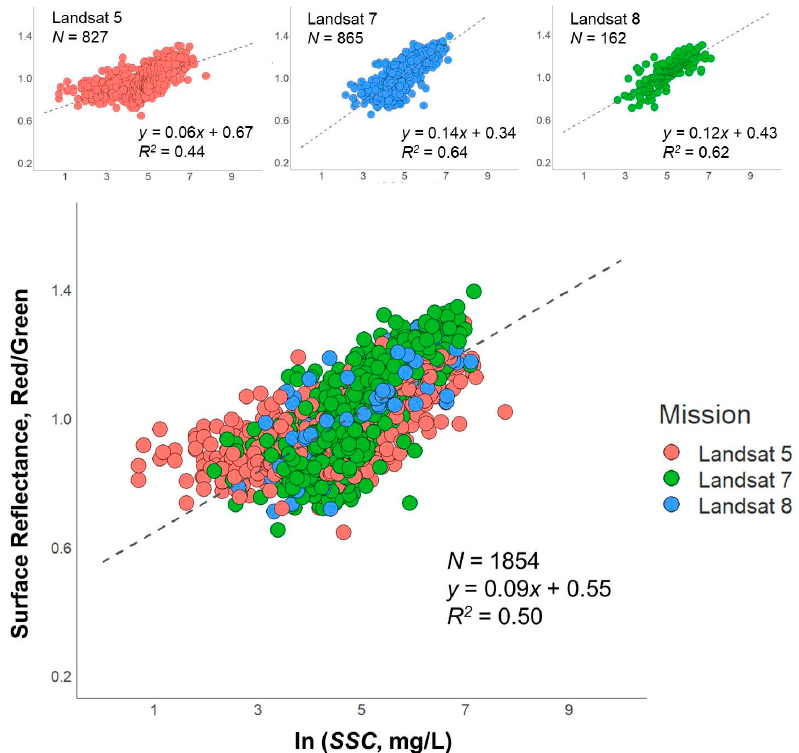
Figure 9. Regional SSC-SR models for the Upper Mississippi River. Top panel: regression models for each Landsat mission. Bottom panel: regional regression model for all the Landsat missions.